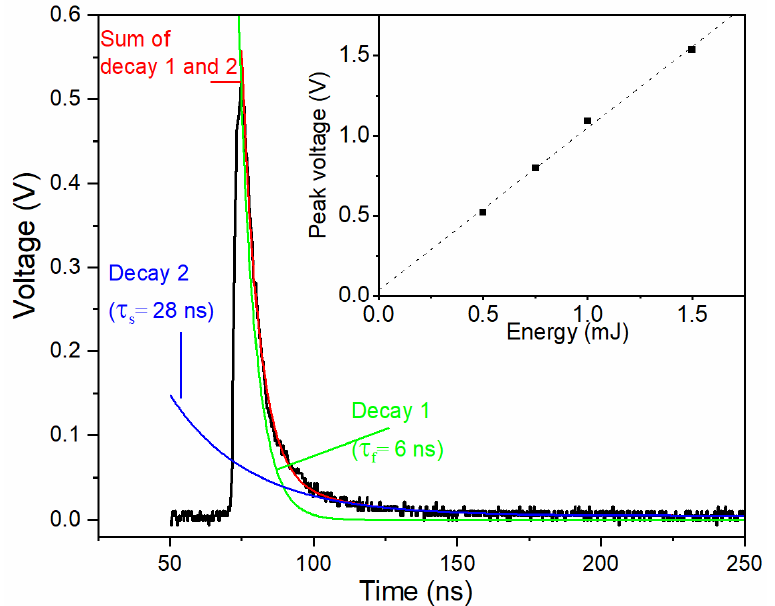
Figure 4. TTE voltage signal of YBCO thin film laser detector under the irradiation of pulse laser with the wavelength of 1000 nm and the repetition rate of 1 Hz. Exponential decay fits for decay time are shown, including the fast component of decay 1 (in green), the slow component of decay 2 (in blue), and the sum of decay 1 and 2 (in red). The inset shows the linear relationship between peak voltage and pulse energy. Table 1. The summarized details of signal decay time and thermal conductivity of various materials.